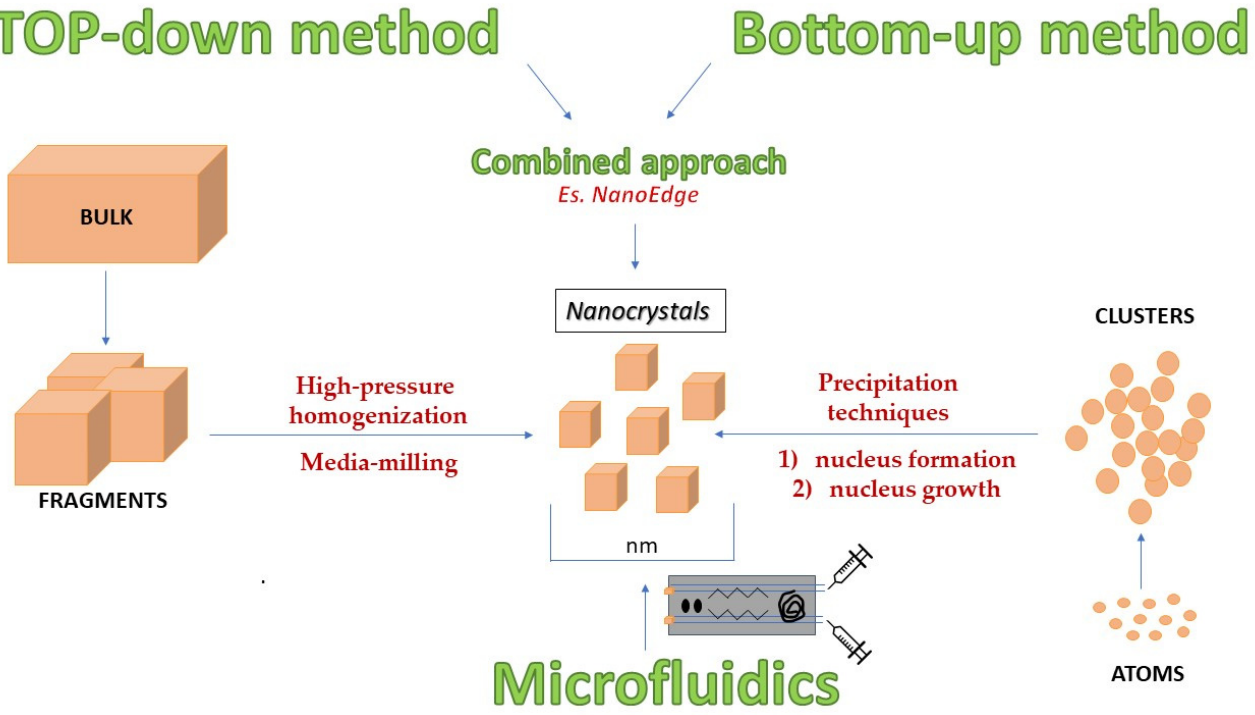
Figure 1. Main nanocrystal production techniques: Top-down method, Bottom-up method, combined approach, and the new microfluidic technique.